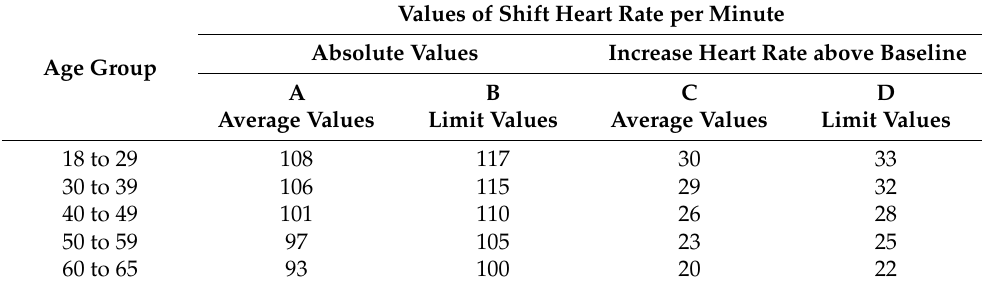
Table 2. Criteria for assessing the change in heart rate at work